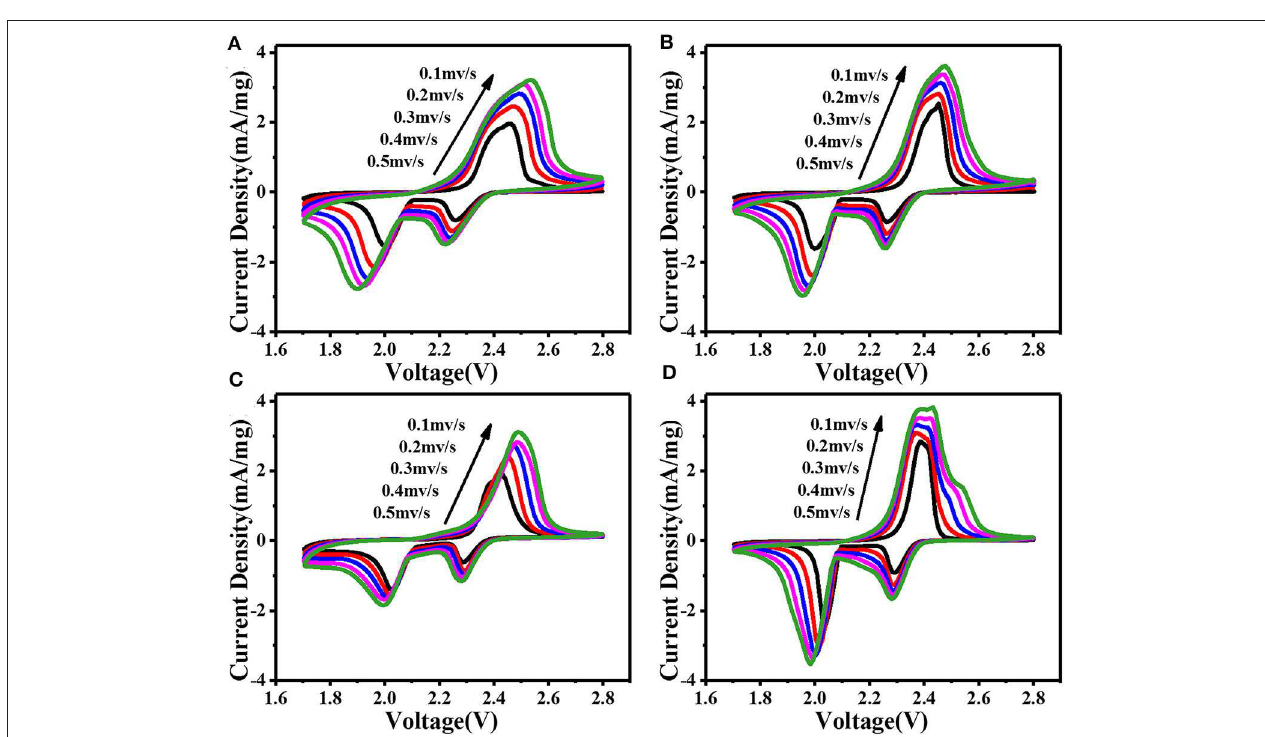
Furthermore, the cathode peak around 2.0 V corresponds to the transformation of long-chain polysulfide into insoluble Li 2 S or Li 2 S 2 (Chung et al., 2016). In subsequent anode scanning, the